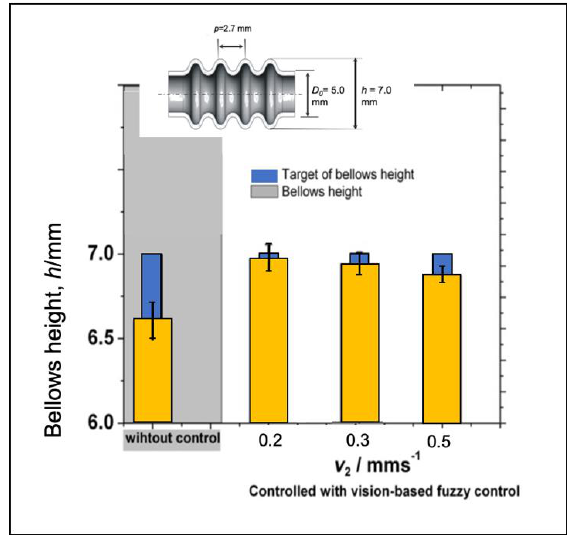
Figure 20. Evaluation of the bellows height under different initial compression speeds.